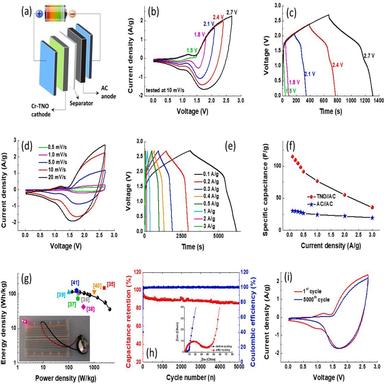
Performance of ASCs based on Cr-TNO and AC. (a) Schematic representation of the assembled structure of the Cr-TNO//AC ASC. (b) CV and (c) GCD profiles of the ASC, recorded in various potential windows. (d) CV profiles recorded at various scan rates. (e) GCD profiles recorded at various current densities. (f) Specific capacitances of Cr-TNO//AC and AC//AC devices, recorded at various current densities. (g) Ragone plots of the Cr-TNO//AC ASC (inset: digital photograph of an LED lighted by the ASC). (h) Cyclin